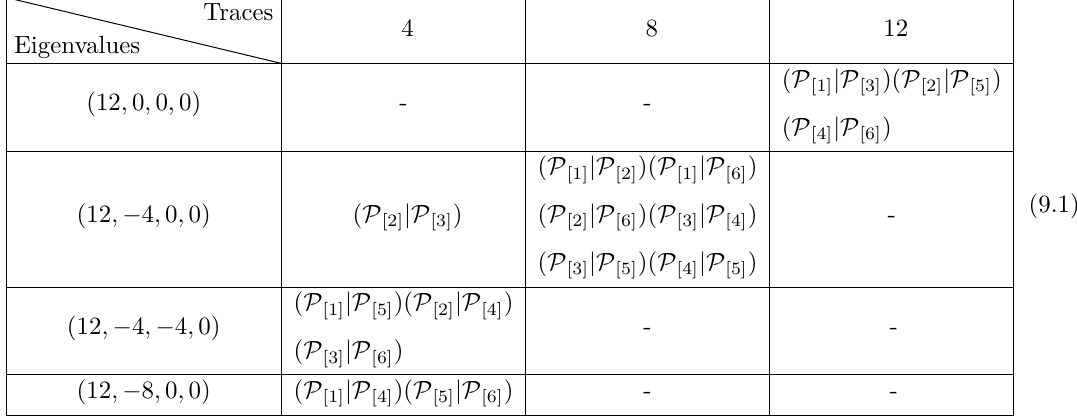
Table 23. Eigenvalue/trace distribution of two-point correlator